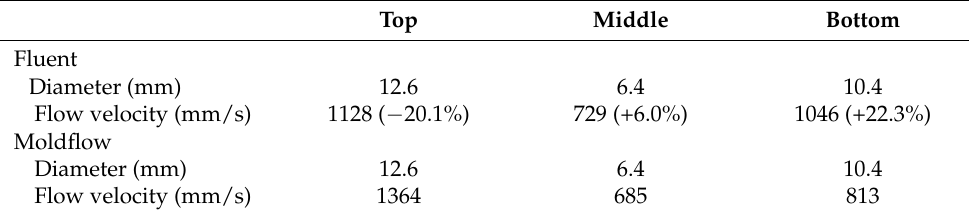
Table 2. Comparison of analysis results of Moldflow and Fluent.